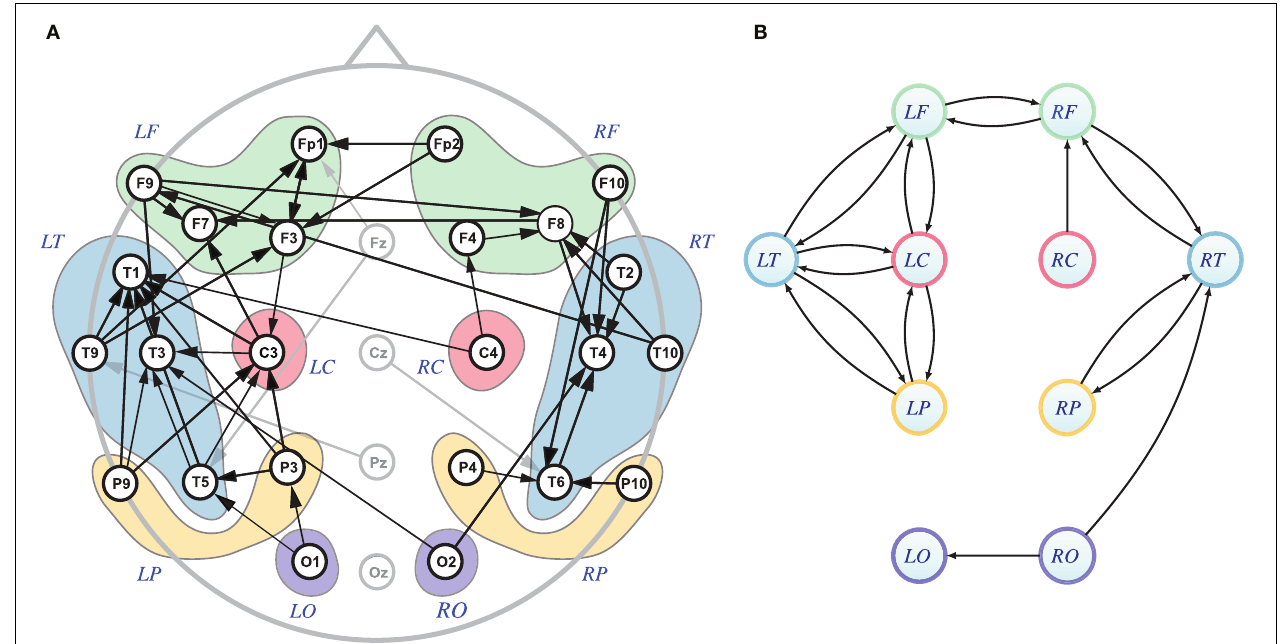
FIGURE 8 | (A) This corresponds to Figure 7.13 from Sameshima et al. (2014) showing the gPDC connectivity graph (see arrows) and the scalp electrodes grouping sets corresponding to frontal (LF, RF), temporal (LT, RT), central (LC, RC), pariental (LP, RP), and occipital (LO, RO) areas. The midline electrodes in gray were not considered in this analysis. (B) Diagram for the significant first cPDC components in Figure 7 (red